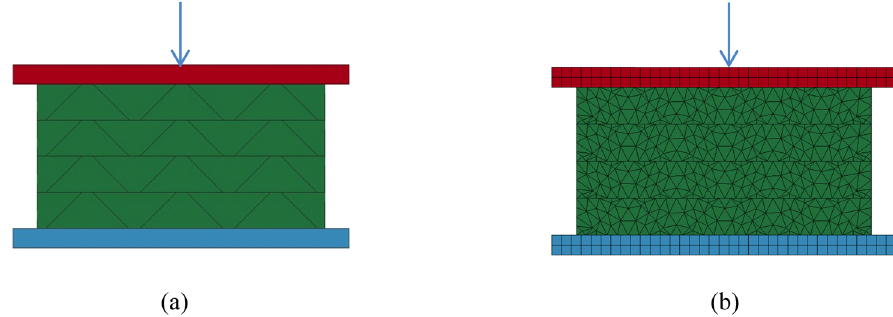
Figure 11: Geometric model and mesh mode of TS - T - A45: ( a ) geometric model and ( b ) mesh mode.